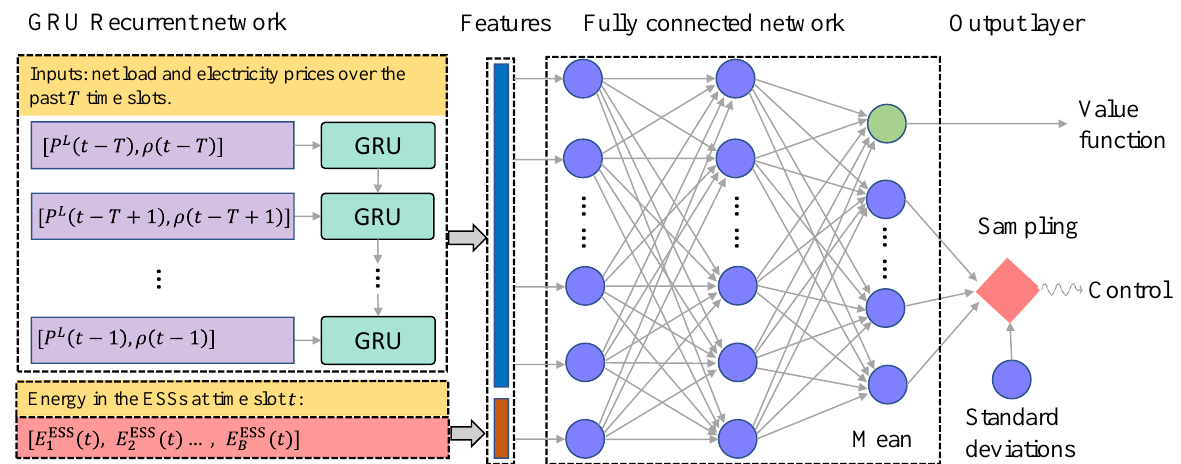
Figure 1. The architecture of the designed policy and value network. The overall network includes three parts: (1) the GRU network, which takes as inputs the net load and electricity prices of the past T time slots and outputs features about their future trends; (2) the feed-forward network, which concatenates the features extracted by GRU and the energy of ESSs at time slot t ; and (3) the output layer outputs the approximated value function and the control